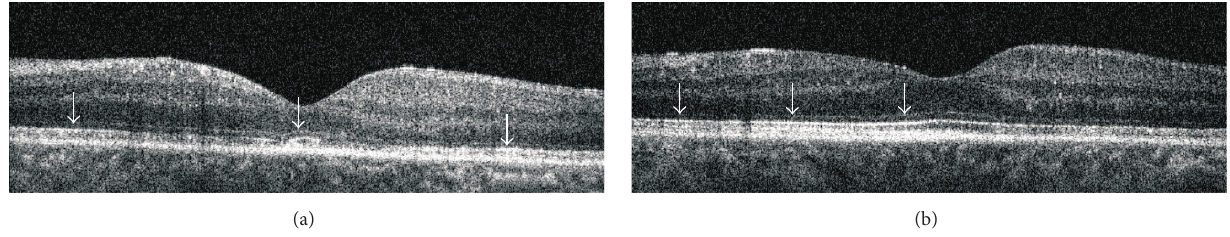
Figure 2: Asymmetrical increase of the IS/OS reflectivity after pars plana vitrectomy in central SdOCT cross section. (a) 4 weeks after surgery two areas of increased IS/OS reflectivity can be found in the foveola and parafovea (arrows). (b) 72 weeks after surgery area of normal IS/OS reflectivity appeared in foveola, parafovea, and nasal part of the fovea (arrows).